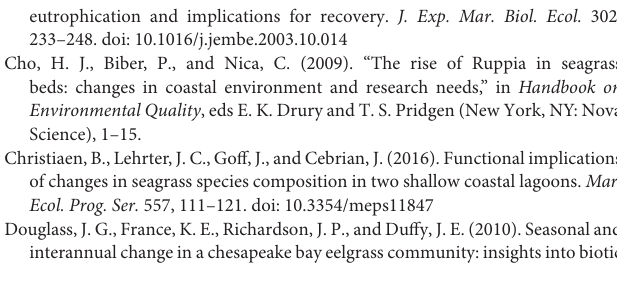
FIGURE S1 | The three locations where the study took place in the lower Chesapeake Bay, VA, United States. Mobjack is the “embayment site” referred to in the methods section, and the two fringing marsh wave-exposed sites are Goodwin and Poquoson. FIGURE S2 | Daily mean water temperatures at the three sites during the sampling events and throughout the summer. Mobjack is the “embayment site” referred to in the methods section, and the two fringing marsh wave-exposed sites are Goodwin and Poquoson. TABLE S1 | Mean biomass of seagrass canopies ± standard error during the growing season. Mobjack is the “embayment site” referred to in the methods section, and the two fringing marsh wave-exposed sites are Goodwin and Poquoson. TABLE S2 | Small epifaunal invertebrates (isopods, amphipods, gastropods and decapods) found in grab samples. Values are means ( n = 3) ± standard error. G, M, and P correspond to the site names Goodwin, Mobjack and Poquoson. Mobjack is the “embayment site” referred to in the methods section, and the two fringing marsh wave-exposed sites are Goodwin and